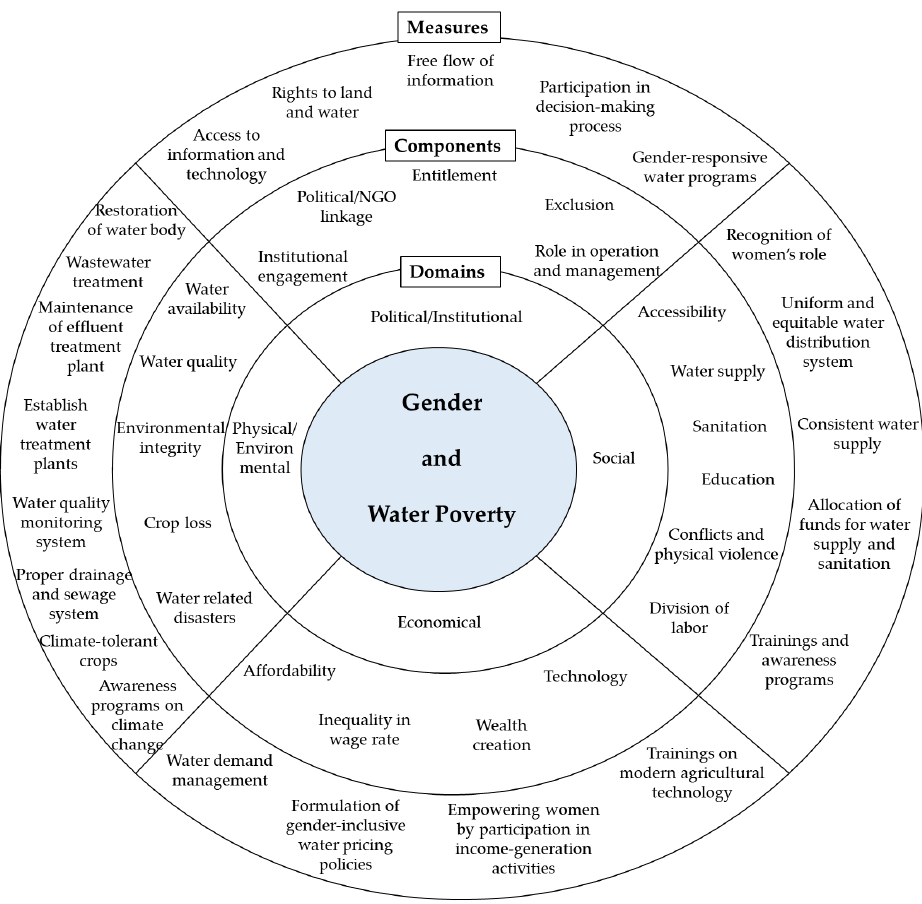
Figure 13. Gender-inclusive water management framework for the water-poor groups in peri-urban area.